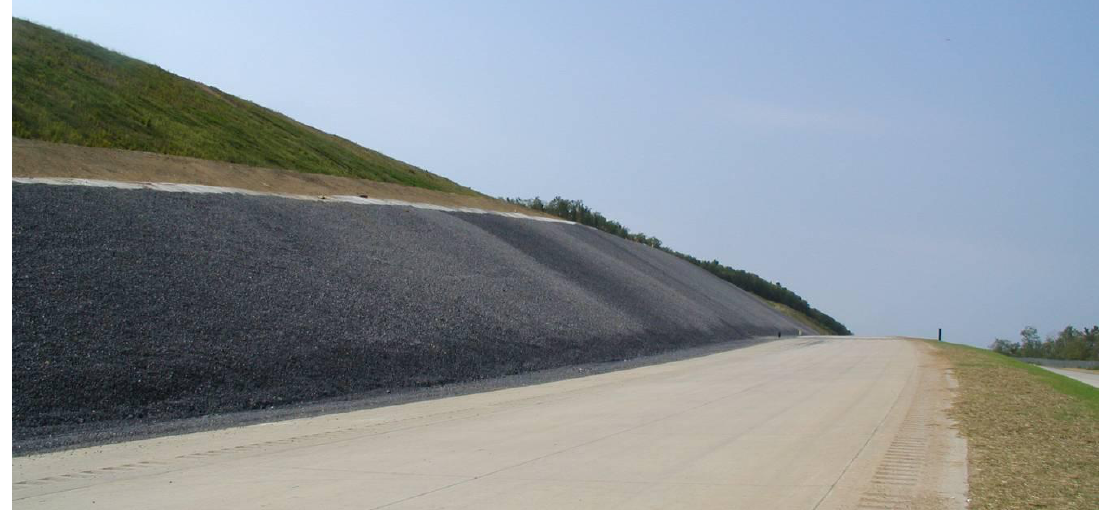
Figure 12. Photo showing appearance of a section of armored slope cover following aggregate infill.